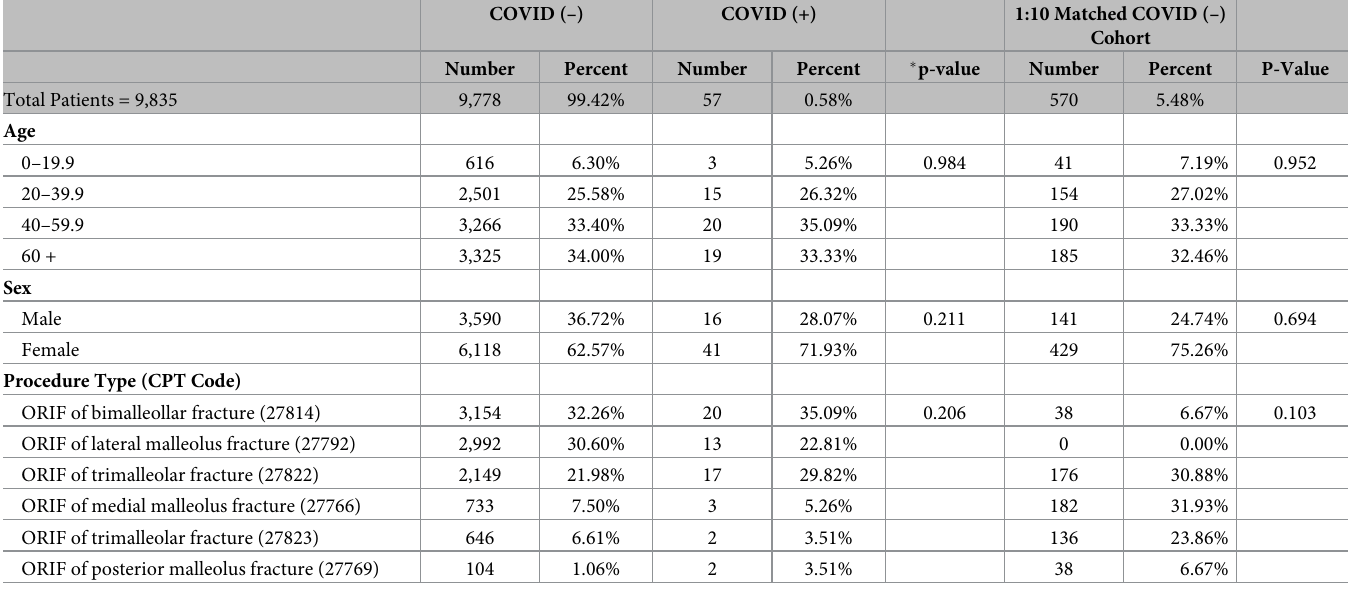
Table 1. Demographic and comorbid characteristics of ankle fracture patients by COVID